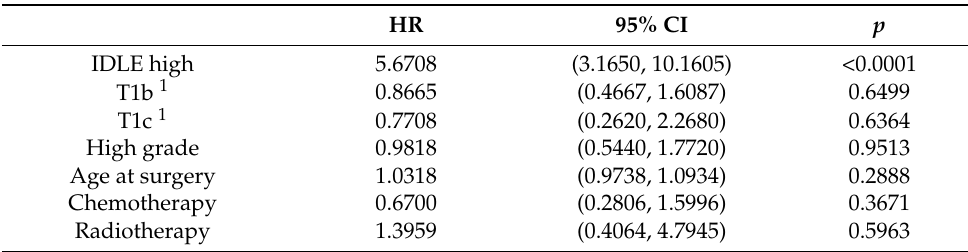
Table 2. Multivariate analysis to study the added value of